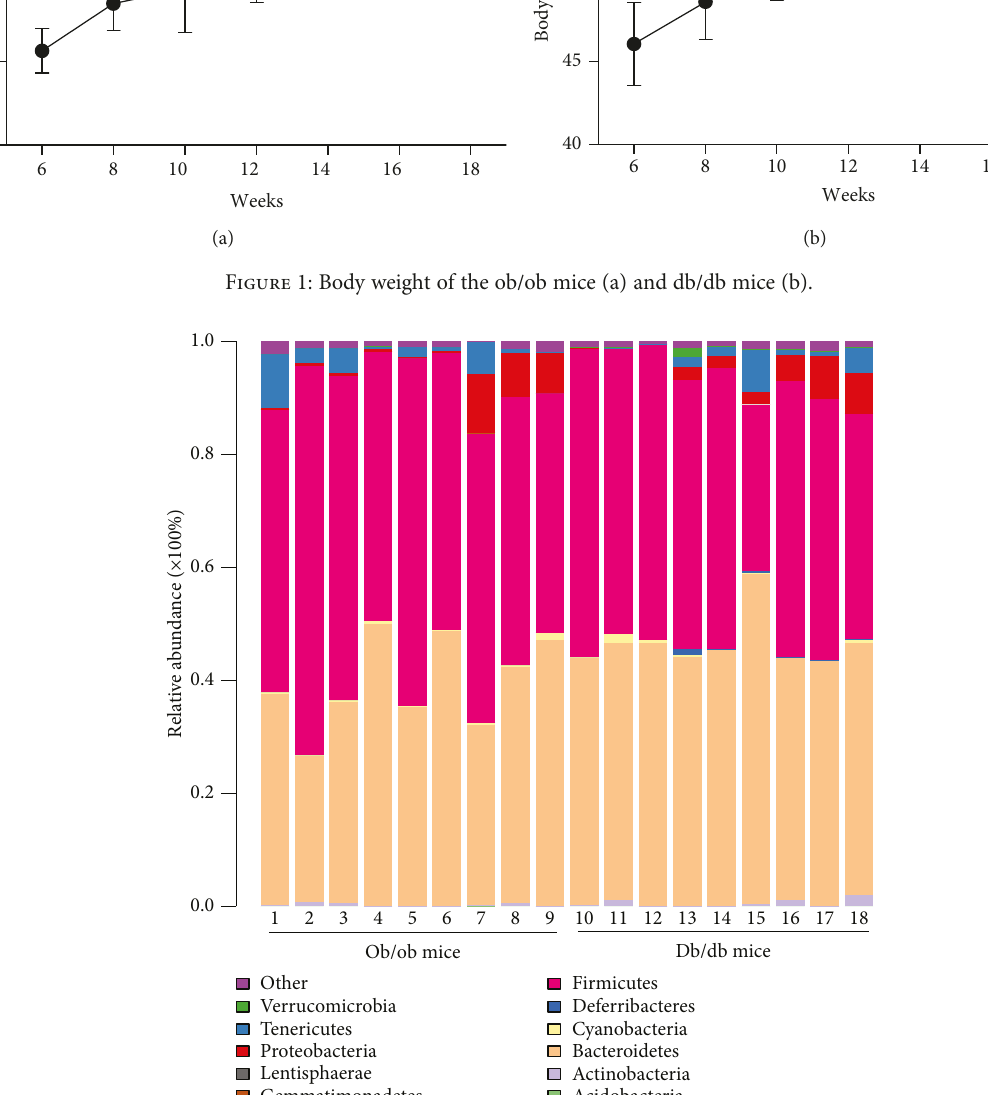
Figure 2: Relative abundance of the major OTUs at the phyla level of the fecal samples from ob/ob and db/db